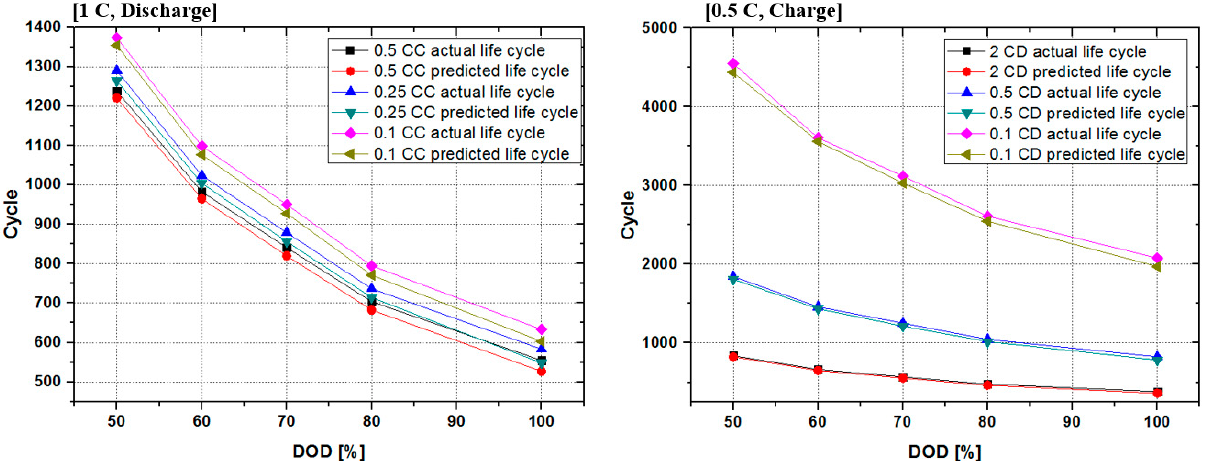
Figure 12. The comparison curve of the predicted life cycle and the actual life cycle.